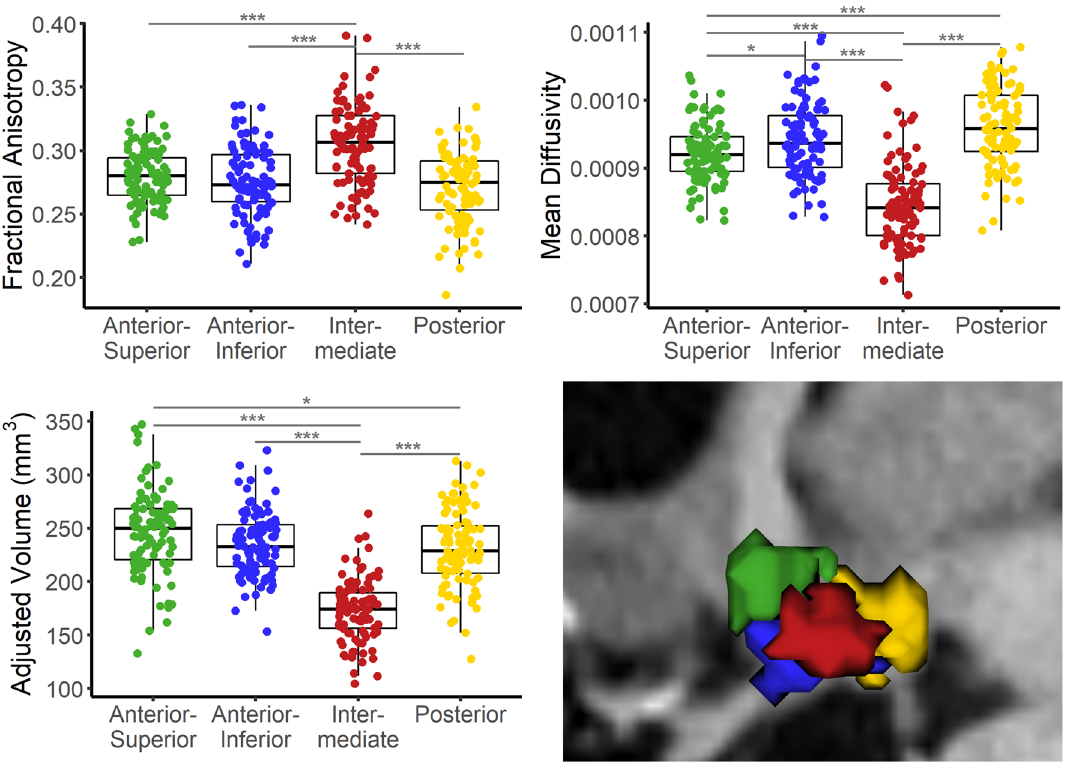
Figure 2. Clustering results in 3D sagittal view exemplary for one participant (bottom right), and boxplots displaying intracranial volume-corrected cluster volumes (bottom left), fractional anisotropy (top left), and mean diffusivity (top right) for each participant. Tukey’s HSD post hoc test results: ***p < 0.001, *p < 0.05.